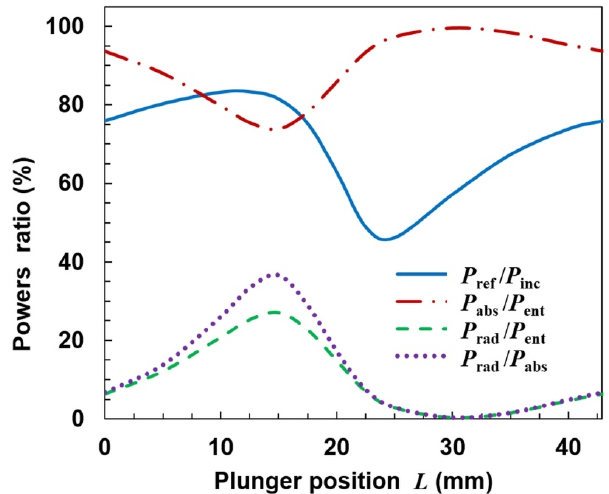
Figure 14. Dependence of power ratio on movable plunger position for closed configuration.